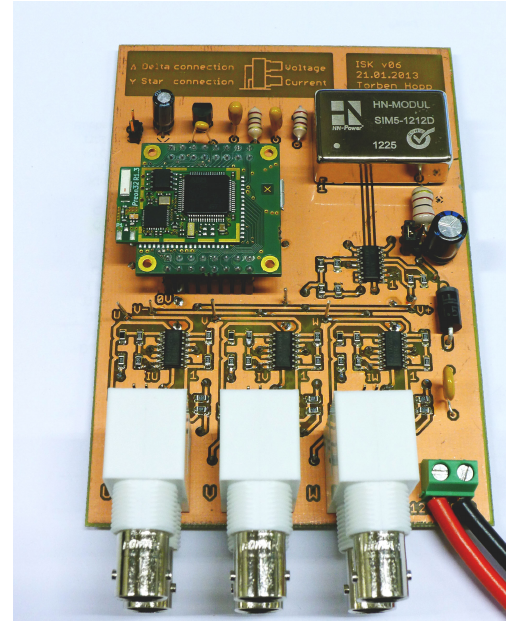
Figure 4. Conditioning board of currents and voltages without housing.